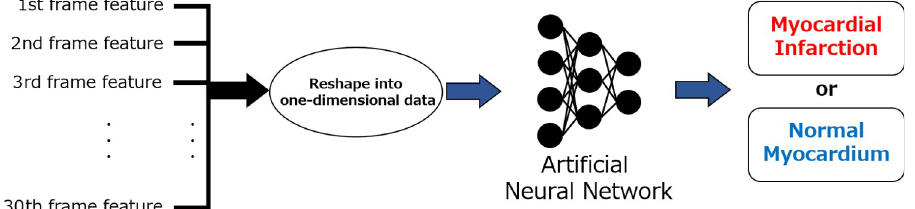
Fig 11. Schematic representation of the artificial neural network classification of myocardial infarction and normal cases. Features from 1 to 30 frames were transformed into one-dimensional data and input into an ANN.